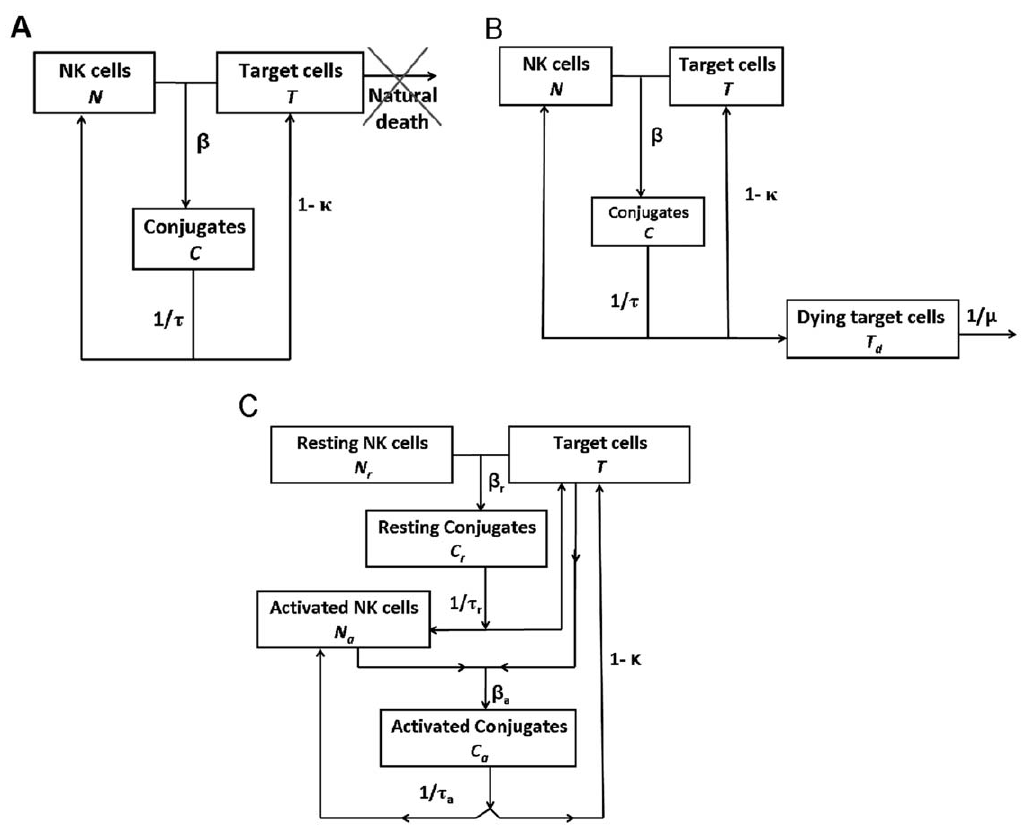
Figure 1. Modelling NK cell activation dynamics. A ) The Basic model. The variables represented by this model are: N – the number of free NK cells; T – the number of free target cells; and C – the number of NK-target cell conjugates. The Parameters that govern the behaviour of these populations are: b - the conjugation rate (cells*min) 2 1 ; t - the conjugate lifetime (min), such that conjugates will break up at rate 1/ t (min) 2 1 ; and k - the death rate of post-encounter target cells, such that ( 1- k ) is the fraction of living targets returning to the free target population. B ) Model with a delay in cell death. Here, T d is the number of dying target cells; they die at rate m ((min) 2 1 ), such that 1/ m is the dying target cell lifetime (min). C ) Model with a delay in cell activation. The model version shown here does not include target cell death delay. The variables here are: N r – the number of free resting NK cells; N a – the number of free activated NK cells; T – the number of free target cells; C r –the number of cell conjugates of target and resting NK cells; and C a – the number of cell conjugates of target and activated NK cells. Parameters are the same as in the basic model, except for different conjugation and dissociation rates for resting and activated NK cells: b r and t r for resting and b a and t a for activated NK cells, respectively.